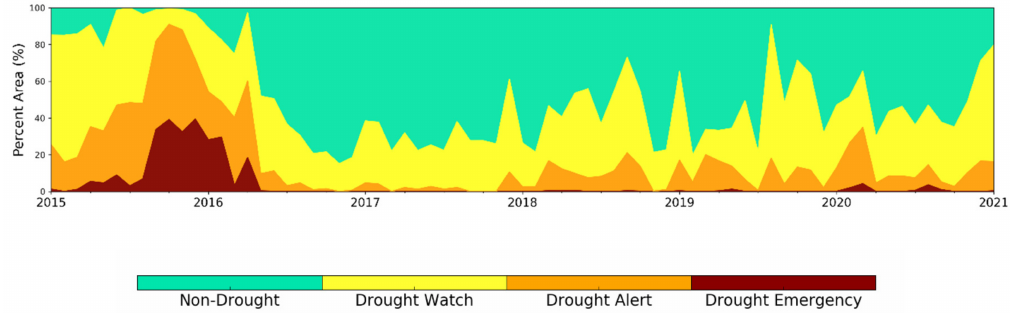
Figure 11. Drought warning stacked area chart over the study period.